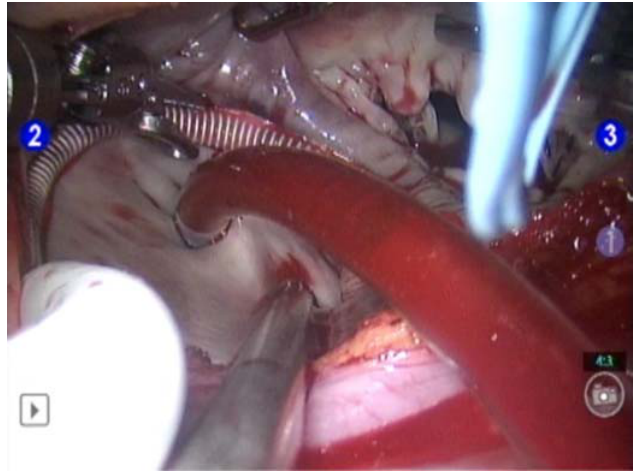
Figure 6. Maze lesion forming superior portion of pulmonary vein isolation box.